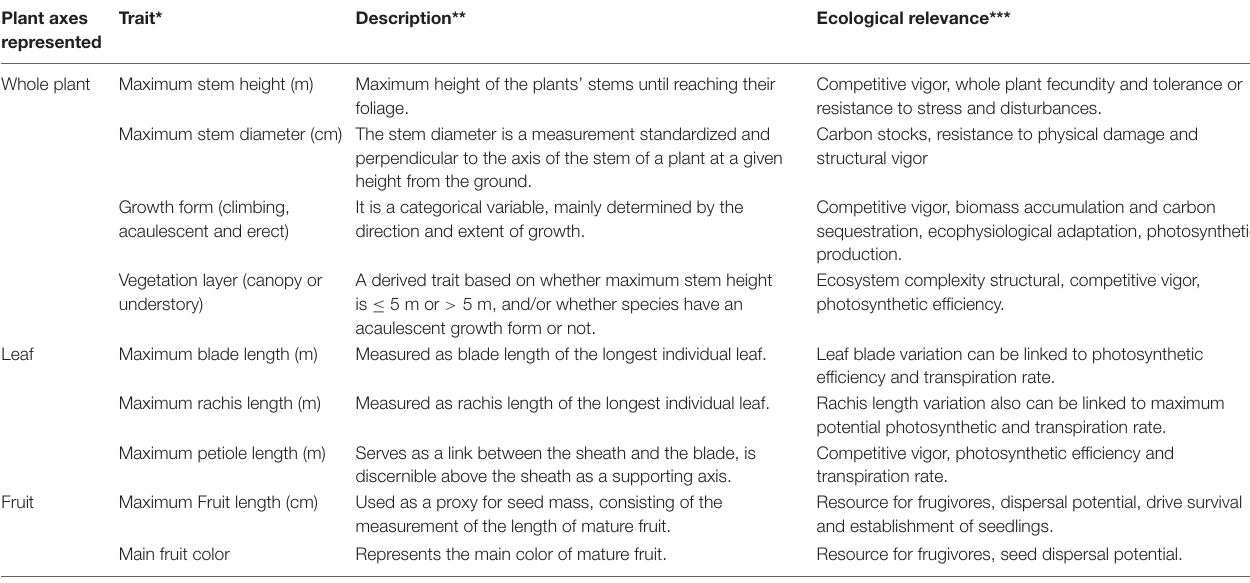
TABLE 1 | Functional traits related to height, leaf and fruit characteristics used to obtain functional diversity in cocosoid palm species and their ecological relevance. Plant axes represented